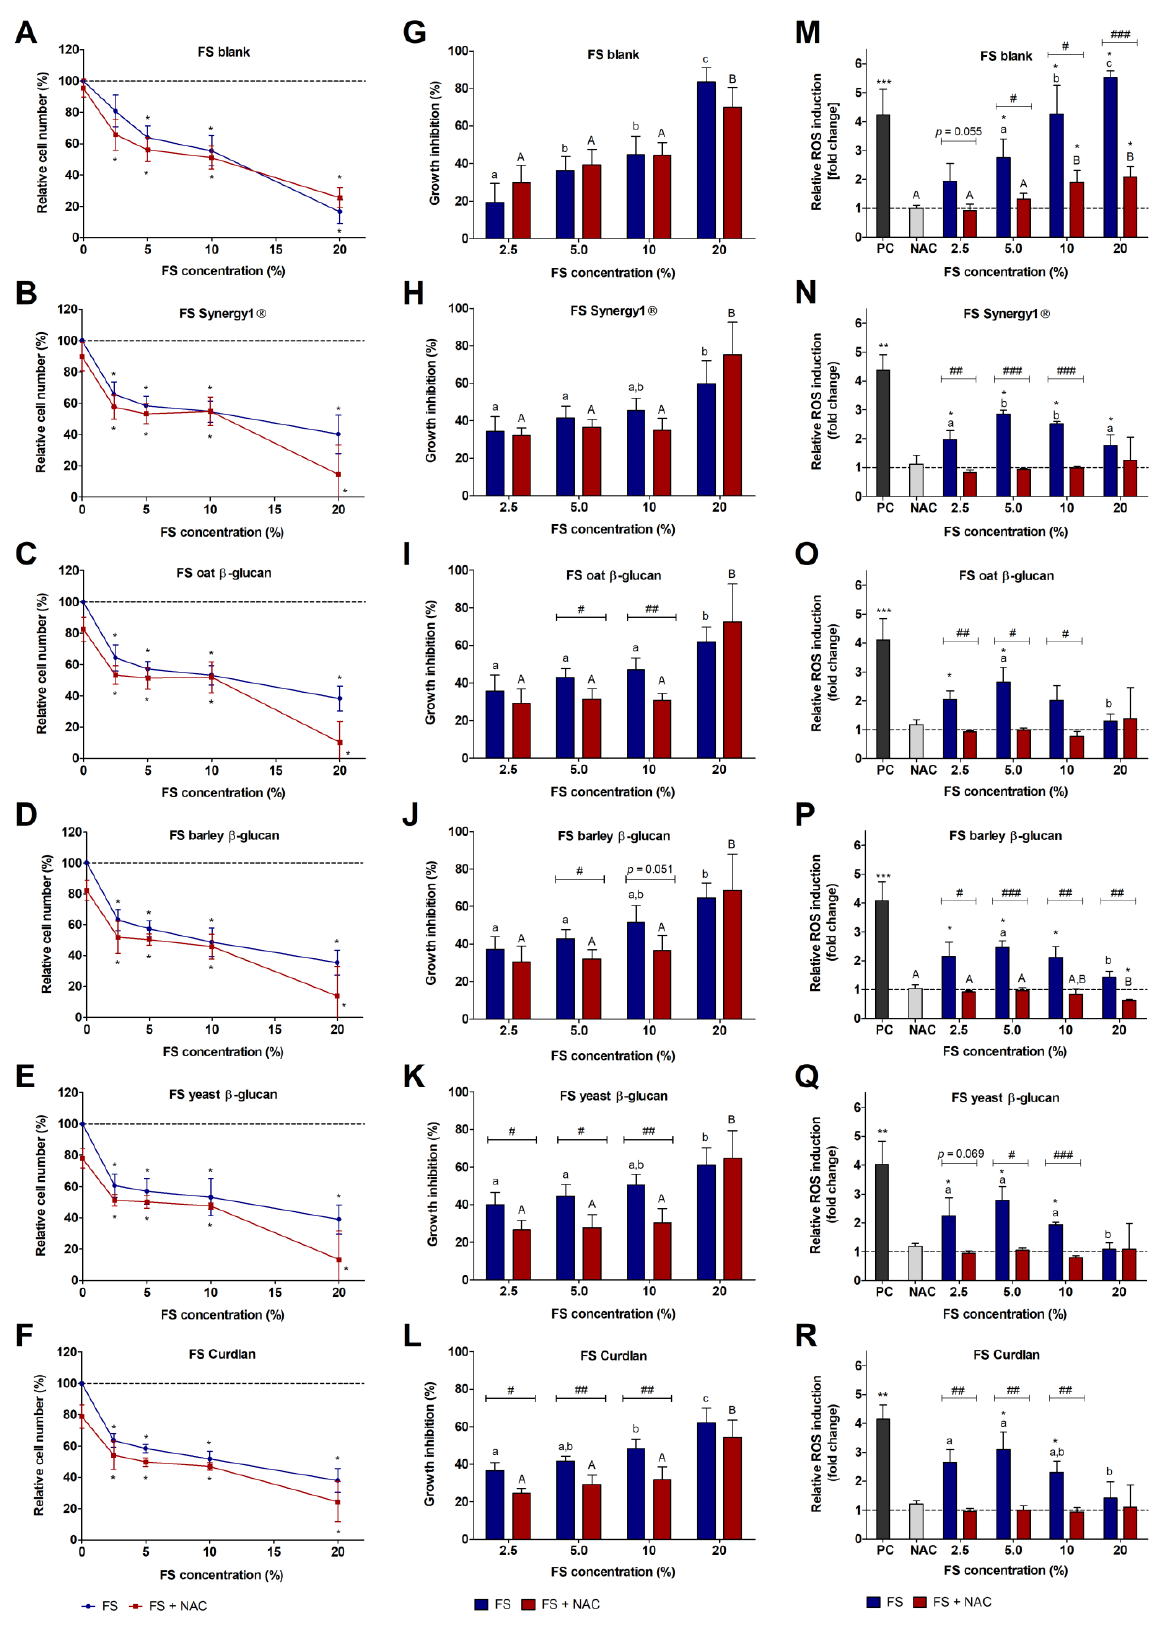
Figure 1. Relative number (%) of LT97 colon adenoma cells ( A – F ), growth inhibition rate (%) of LT97 cells ( G – L ), and relative ROS induction (fold change) in LT97 cells ( M – R ) after treatment with